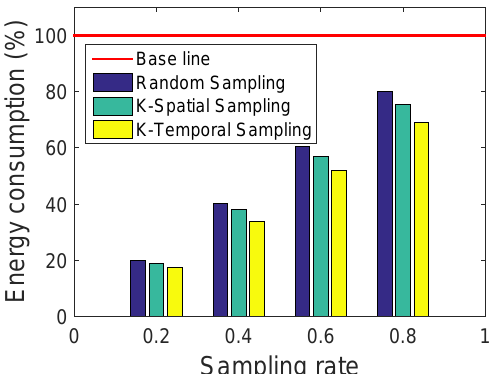
Figure 13. Energy consumption comparisons of link quality estimation between the real trace and LESS (RS, K-S, and K-T) with sampling rates from 0.2 to 0.8.